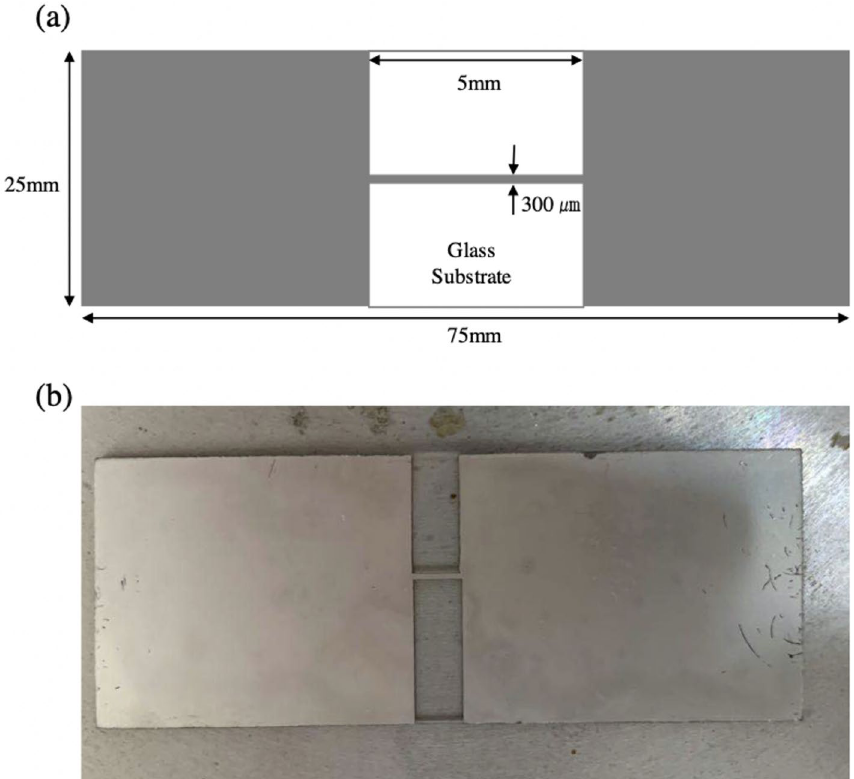
Figure 9. Schematic of the sample ( a ) plan view of the substrate after deposition, ( b ) experimental sample.